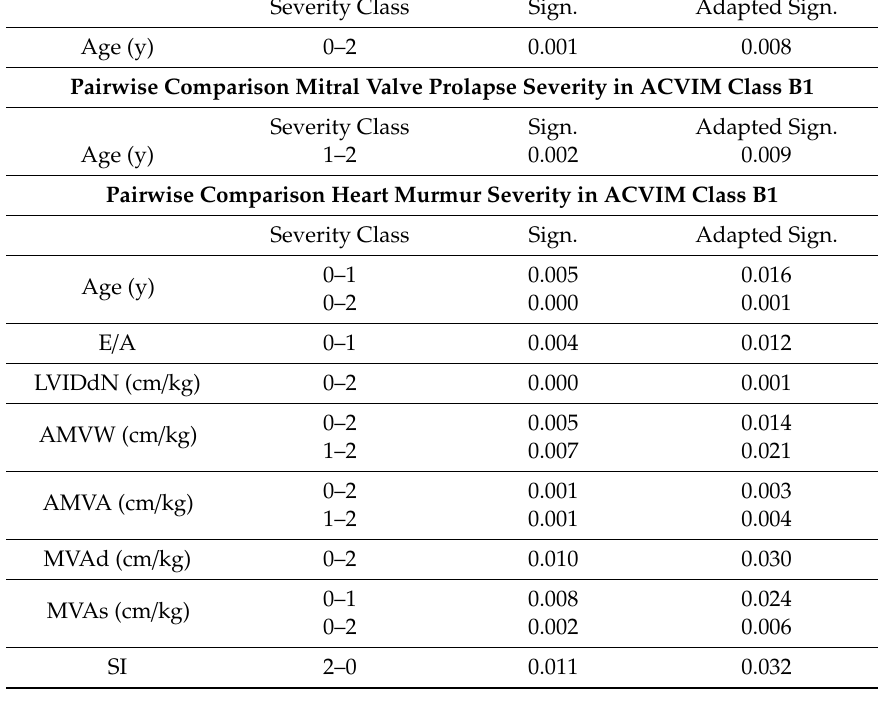
Table 4. Statistically significant di ff erences between clinical findings, indexed echocardiographic measurements and SI of subjects in ACVIM class B1, categorized considering mitral regurgitation, mitral valve prolapse and heart murmur severity. Mitral regurgitation severity: 0 = absent; 1 = regurgitant jet area (ARJ) / left atrial area (LAA) < 1 / 3; 2 = 1 / 3 < ARJ / LAA < 2 / 3; 3 = ARJ / LAA > 2 / 3. Mitral valve prolapse severity: 0 = absent; 1 = under P line; 2 = between P and T lines; 3 = over T line. Heart murmur severity: 0 = absent; 1 = I-II left systolic; 2 = III-IV bilateral systolic; 3 = V-VI bilateral systolic. The significance values have been adjusted according to the Bonferroni correction for more tests. left ventricular internal diameter in diastole normalized for body weight (LVIDdN); anterior mitral valve length (AMVL), width (AMVW), area (AMVA), mitral valve annulus in diastole (MVAd) and systole (MVAs); sphericity index (SI). Pairwise Comparison Mitral Regurgitation Severity in ACVIM Class B1 Severity Class Sign. Adapted Sign. Age (y) 0–2 0.001 0.008 Pairwise Comparison Mitral Valve Prolapse Severity in ACVIM Class B1 Severity Class Sign. Adapted Sign.